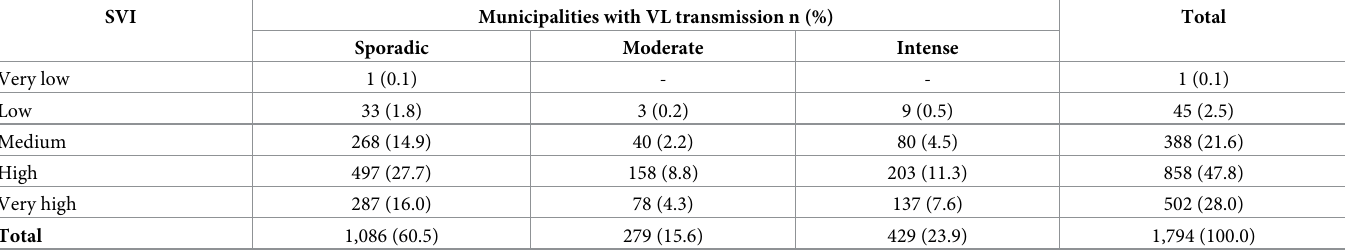
Table 5. Distribution of Northeastern municipalities of Brazil according to social vulnerability and VL transmission.